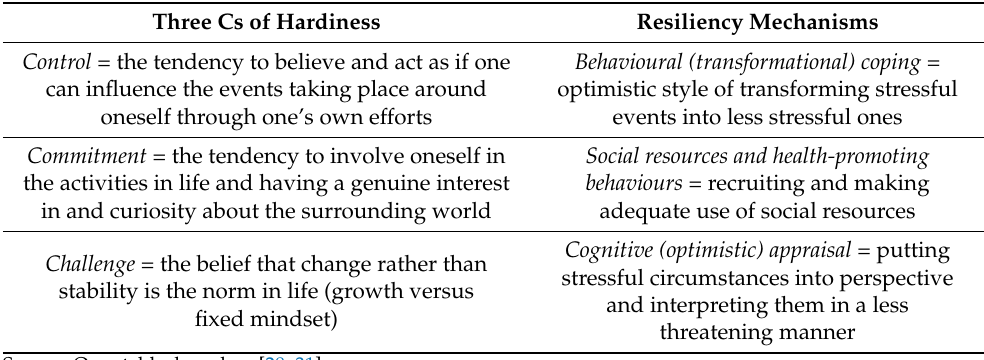
Table 1. Comparison of Kobasa’s Three Cs of Hardiness [29] with her Resiliency Mechanisms [28,30,31]. Three Cs of Hardiness Resiliency